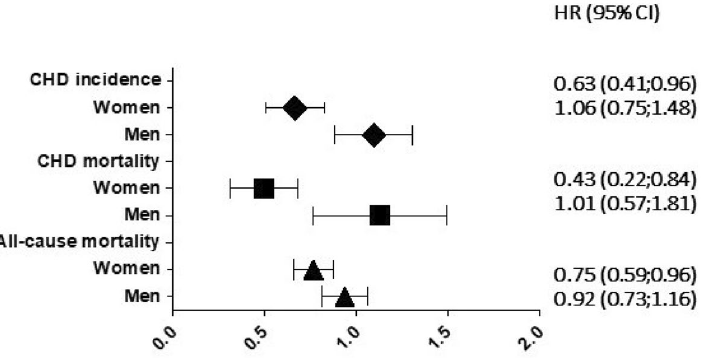
Figure 3. Marital status hazard ratios for three out of seven outcomes in approximately 20 years in the Gubbio Population Study, adjusted for age, SBP, total and high-density lipoprotein cholesterol, cigarettes and BMI in women and in men. See also Tables 2 and